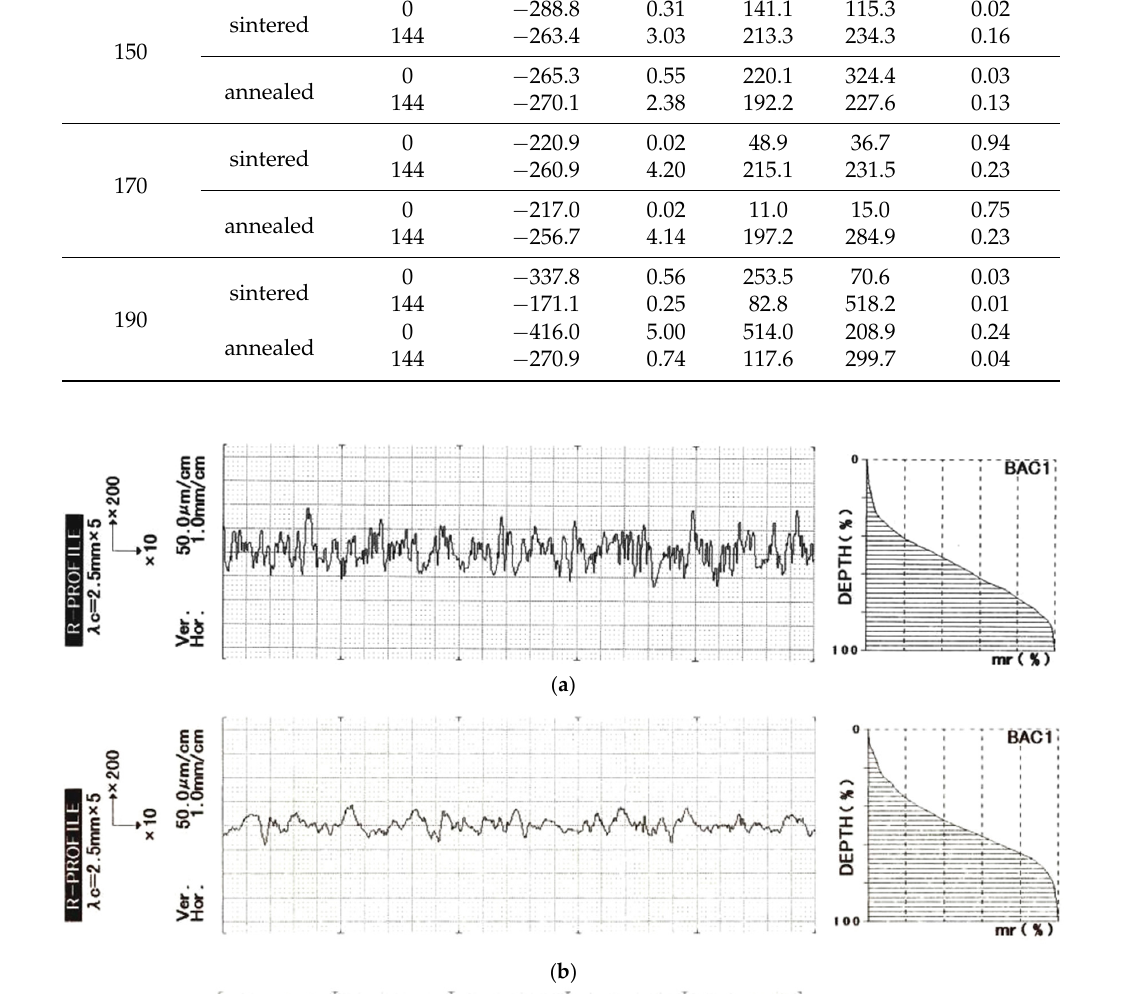
Table 5. Average values of the roughness parameters.